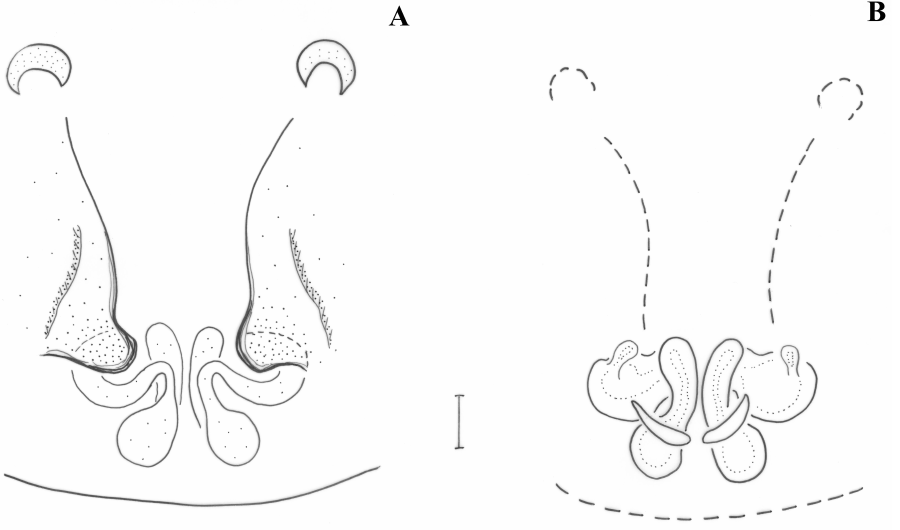
Figure 17. Zelotes olympi (FC: 17048). ( A ) Epigyne, ( B ) vulva. Material Florina, Prespes, 1.9 km NW of Pisoderi (40.79085 N 21.23345 E), beech forest edges, ruderal strip, dry and wet meadows [FC: 17048, 24/06/2014], 1